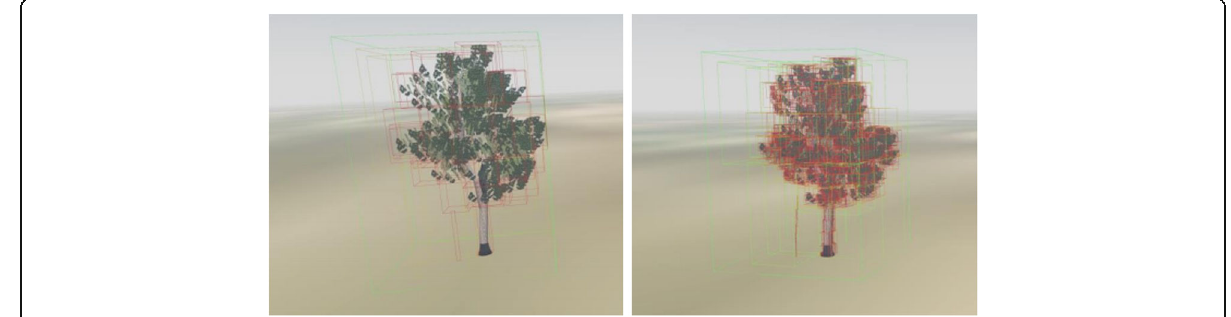
Fig. 5 Hierarchical box tree with different levels (number of layers on the left is 3, on the right is